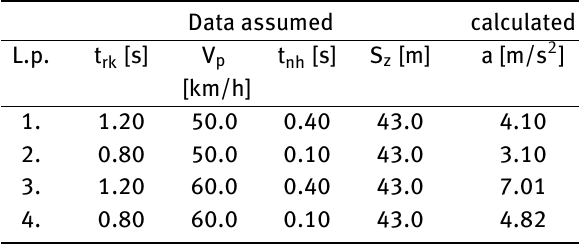
Table 2: Data for calculating the deceleration value with initial assumption bus location S z = 43.0 m, in front of the traflc